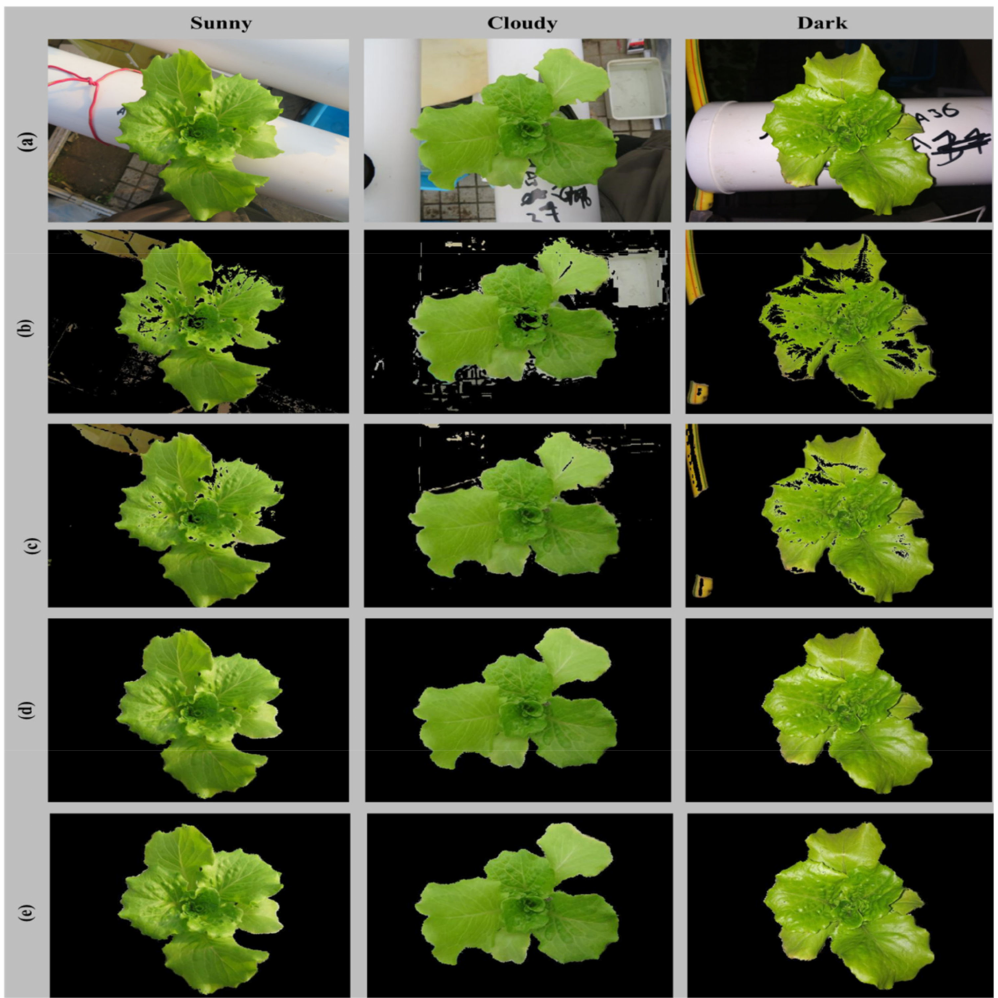
Figure 9. Visual assessment of segmentation methods; the original images ( a ), threshold ( b ), K-means ( c ), SegNet ( d ), and Ground-truth ( e ) of lettuce plants grown in